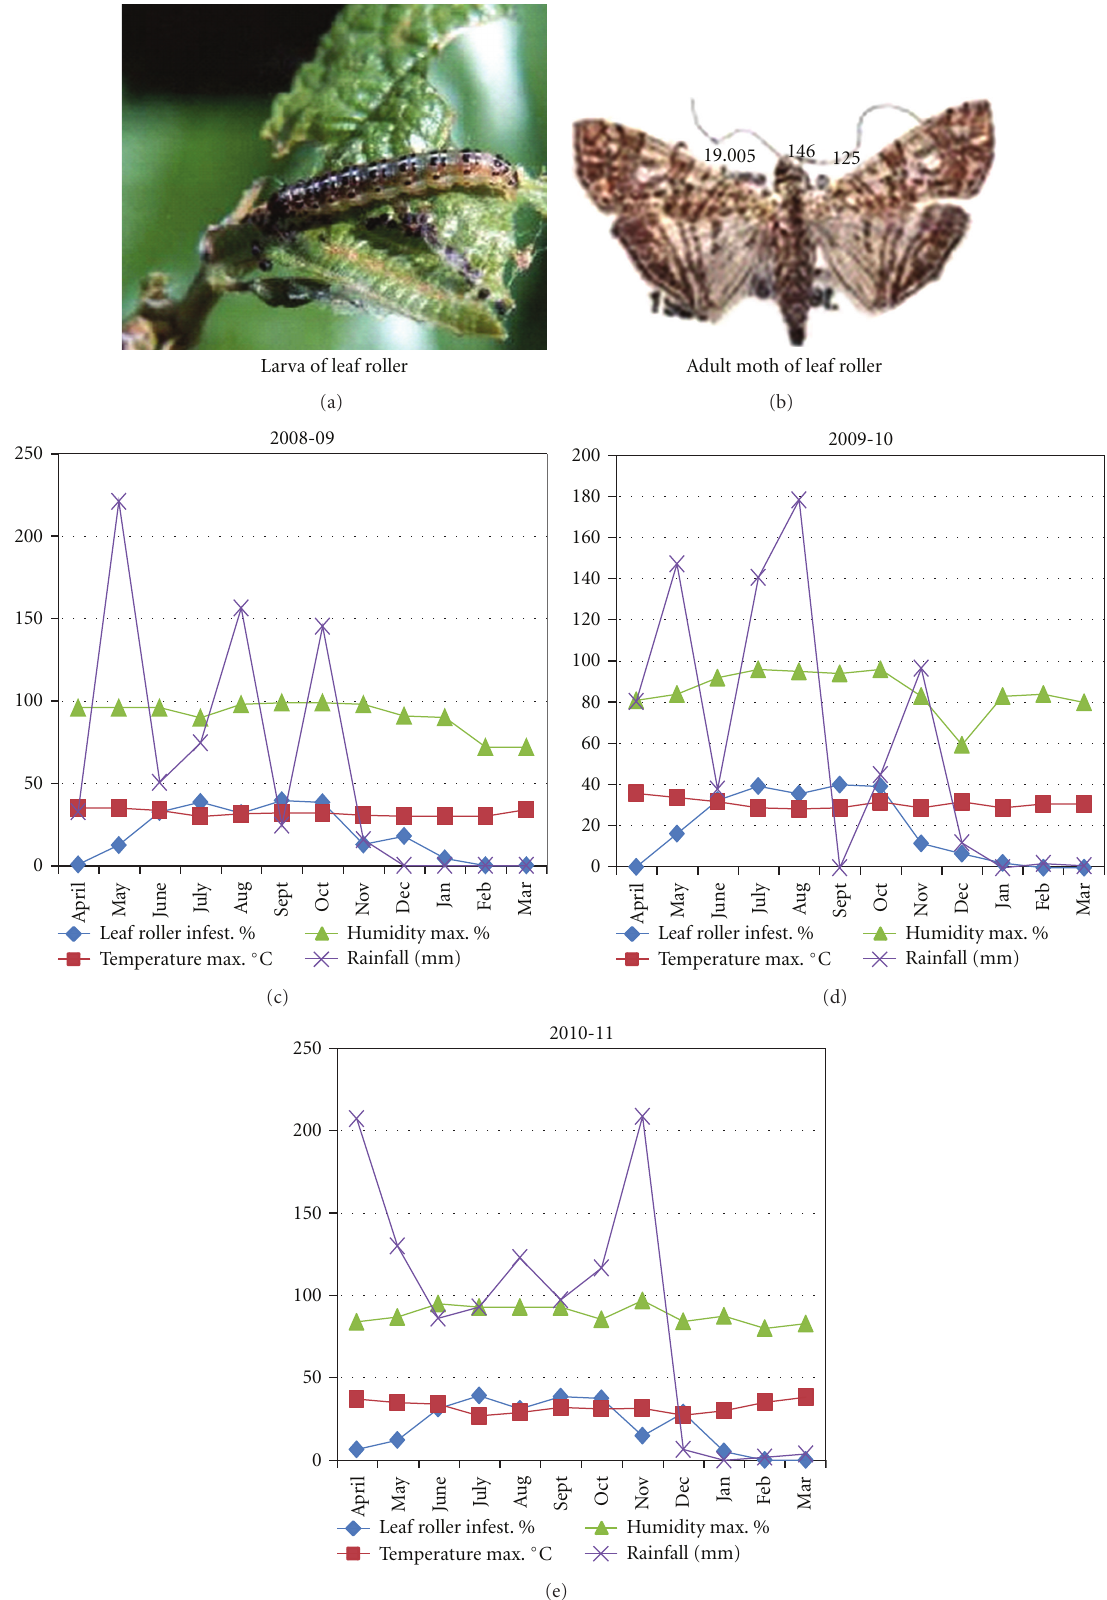
Figure 1: Association leaf roller ( Diaphania pulverulentalis ) infestation and abiotic factors of the study location (3-years